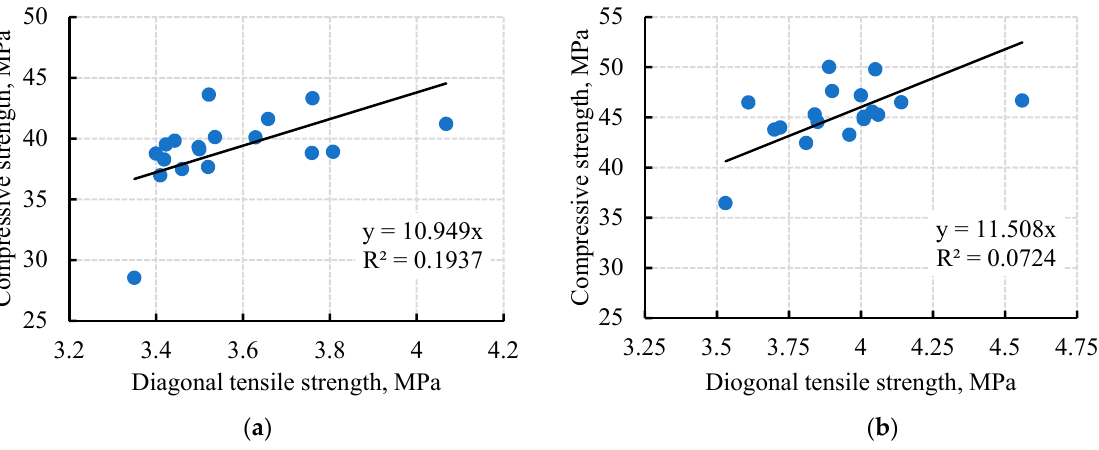
Figure 13. Correlation between the tensile and compressive strengths: ( a ) At 28 days; ( b ) At 56 days.